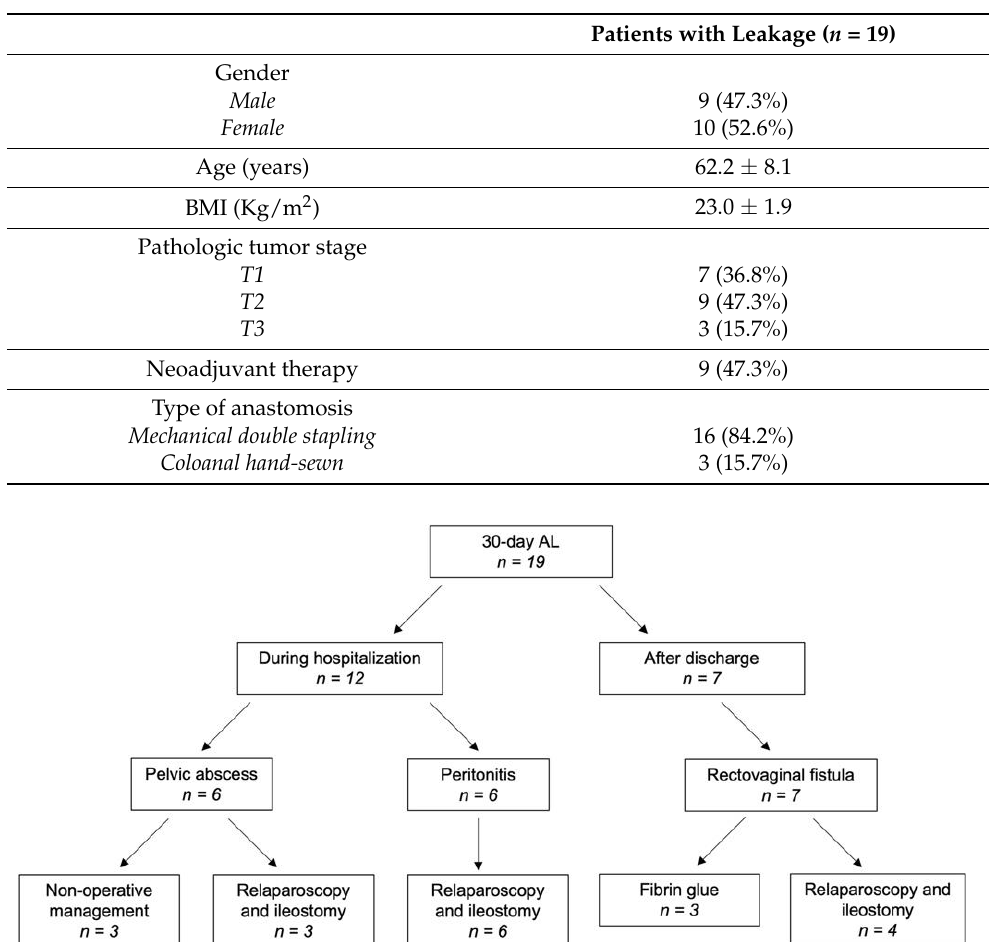
Table 2. Characteristics of the patients affected by anastomotic leakage after laparoscopic TME and transanal tube.